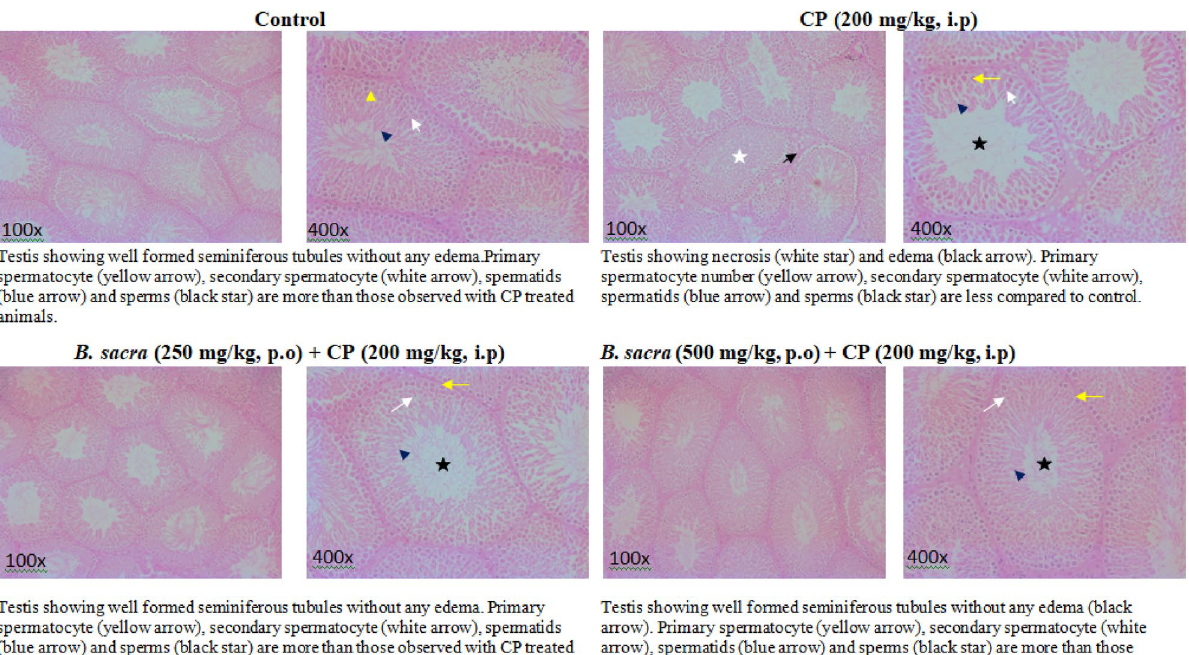
Figure 6. Histological examination of testis.